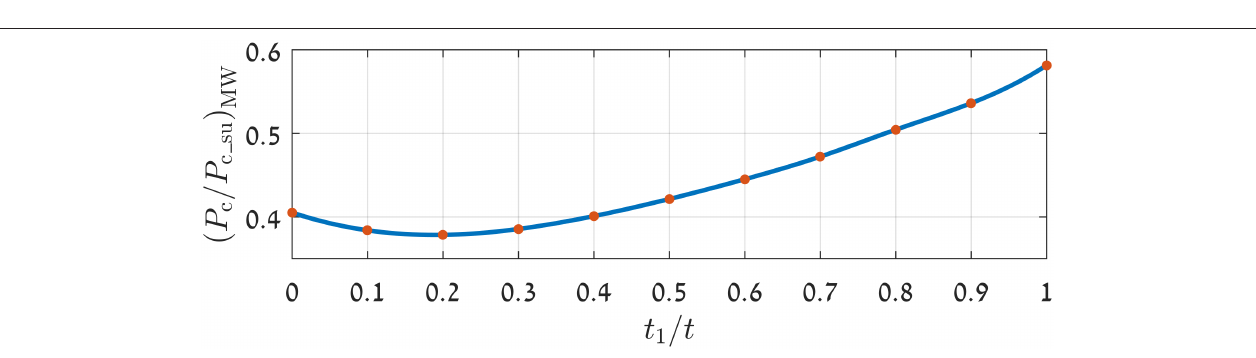
FIGURE 7 | Dimensionless critical load at maximum weakening, ( P c / P c_su ) MW , for different t 1 / t . Material properties as in Table 2 .